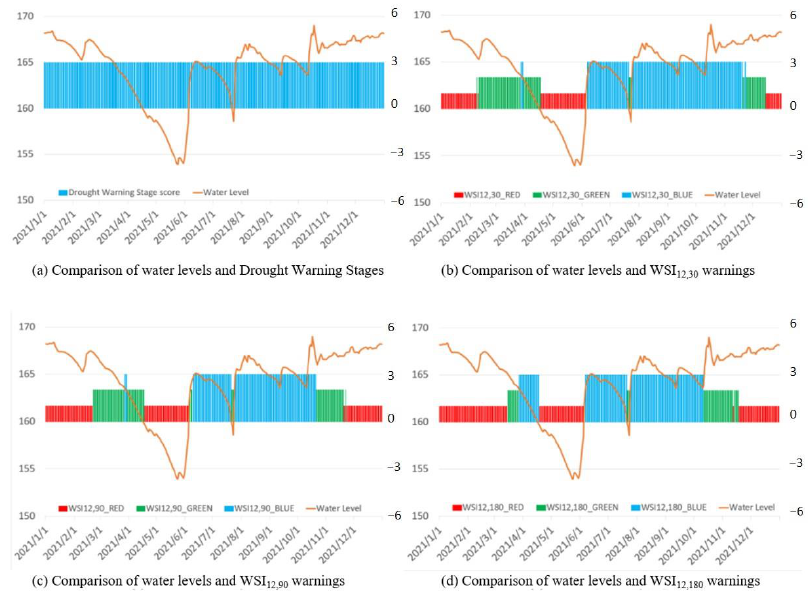
Figure 13. Comparison of the Water Conservancy Drought Warning Stage with the WSI 12,j proposed in this study. When designing the proposed WSI, there is a premise assuming that in the absence of an external force intervention, there is no significant difference between the reservoir water level on a certain day and the average value of the reservoir water level on that day in past years. If the difference is too large, a condition red or condition blue light may be applied. Therefore, if the reservoir water level seems high on one day, why is the condition red light generated? It is purely because the reservoir water level of that day is different from the historical statistical average of that day. Possible solutions to avoid this situation is to consider the historical reservoir water level of that day and the bias ratio of the cur- rent year ’ s reservoir water level at the same time. This issue will be left to other researchers for future research. 6. Conclusions A reservoir is an integrated water resource management infrastructure that can be used for water storage, flood control, power generation, and recreational activities. Pre- dicting reservoir levels is critical for water supply management and can influence opera- tions and intervention strategies. Taking the Feitsui Reservoir as an example, this study proposes a new water survival index to warn users whether there will be a shortage of domestic water in the future. The research results show that compared with the existing water supply monitoring index, the new water survival index proposed in this study can faithfully present the warning of the lack of domestic water in the future. The results of this study are limited to the Feitsui Reservoir. Since the data on the Feitsui Reservoir are relatively complete, and the water supply of the Feitsui Reservoir is limited to the domestic water supply of the Greater Taipei City area, it is easier to estimate the demand for water sources. For many reservoirs that not only supply water for people ’ s domestic water demand, it is not easy to calculate the consumption of water; therefore, the research results of this study may not be very applicable. In addition, when calculating the WSI using a bias ratio, the WSI currently uses moving averages of 6 years and 12 years